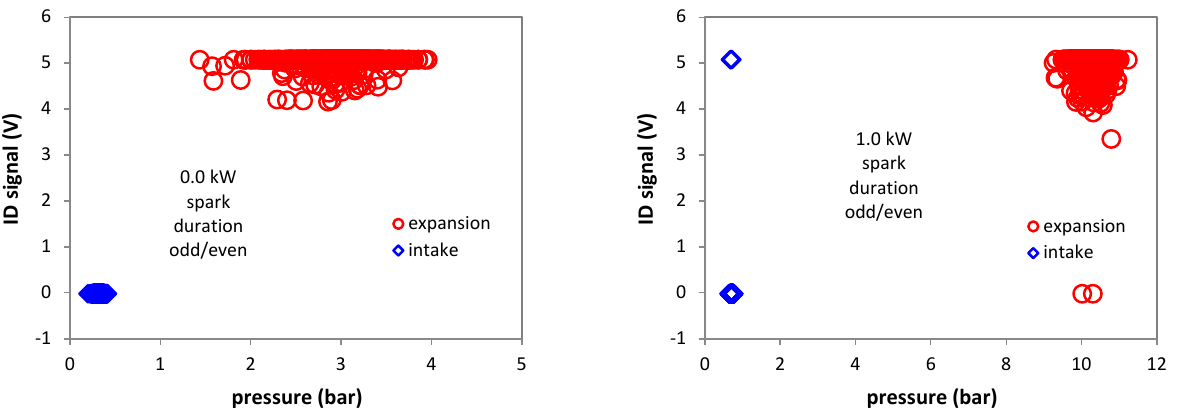
Figure 8. Distribution of the intake/expansion TDC ID signal and in–cylinder pressure for idle and full load conditions when employing the rpm method in odd/even mode.